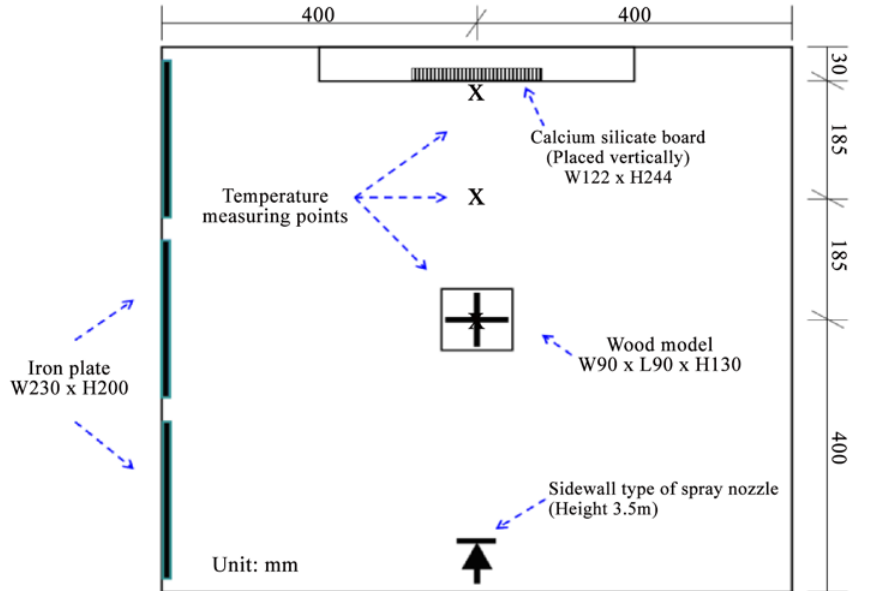
Fig 1. Layout of experimental